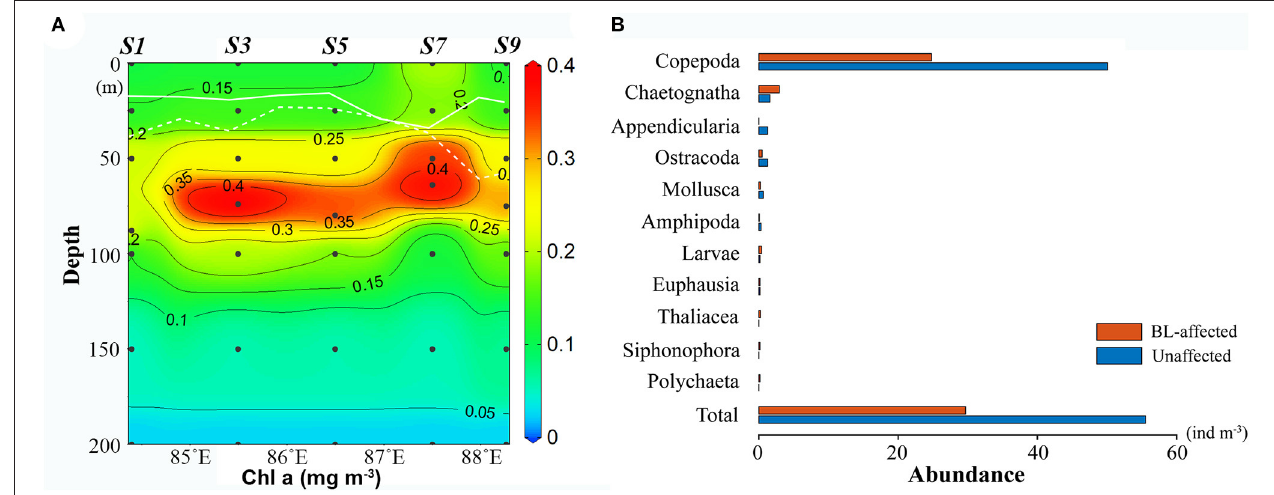
FIGURE 3 | Comparison of the vertical profiles of nitrate (cyan), silicate (yellow), soluble reactive phosphorous (SRP) (red), Chl a (lime), salinity (black, solid), and stability parameter (black, dashed) at the BL-affected station S3 (A) and unaffected station S7 (B) , only the upper 100m are shown. The depth and thickness of the BL at station S3 are